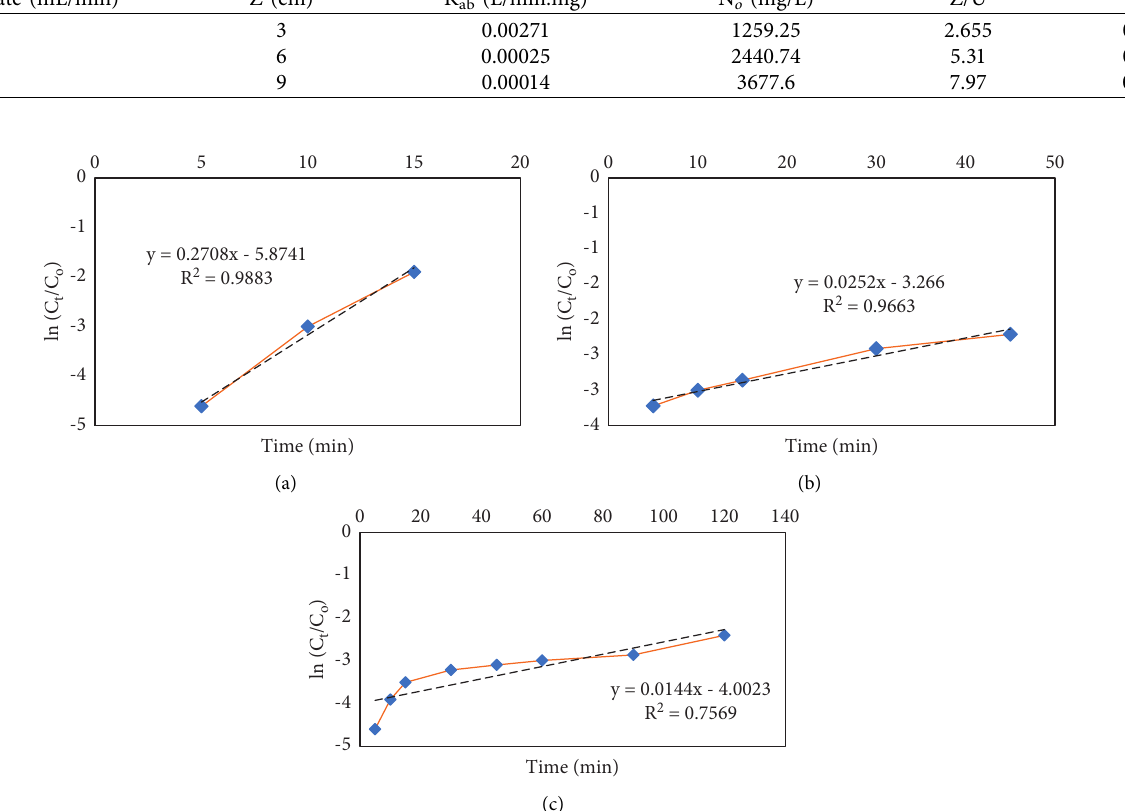
Figure 5: Adams–Bohart model linear form for copper removal at depths. (a) Bed depth of 3cm. (b) Bed depth of 6 cm. (c) Bed depth of 9cm.